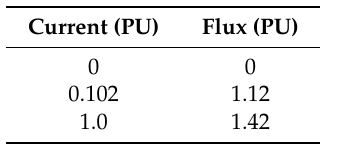
Table 6. Positive magnetization data of the transformer.